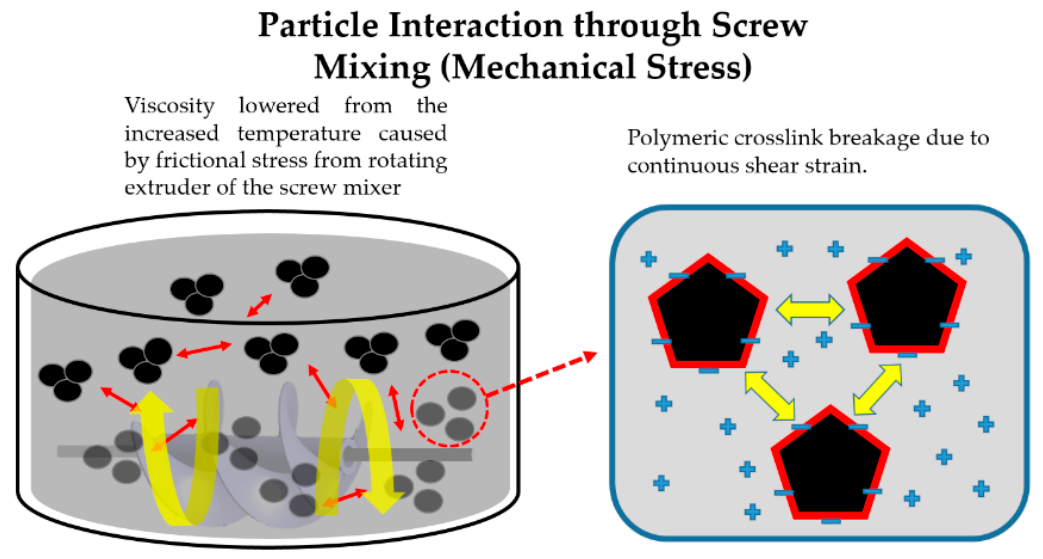
Figure 4. Polymeric degradation due to continuous shear strain of screw-mixing process.